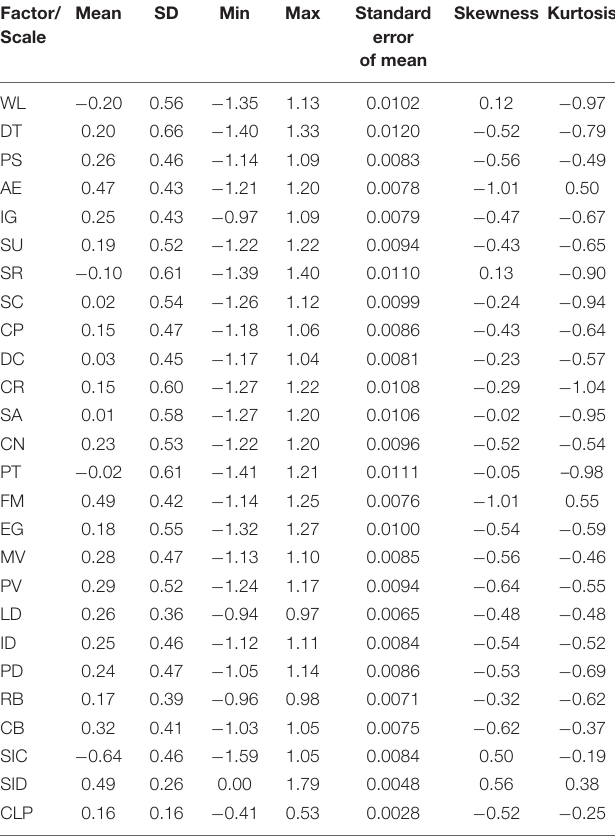
TABLE 2 | Psychometric properties of the MMP scales ( n